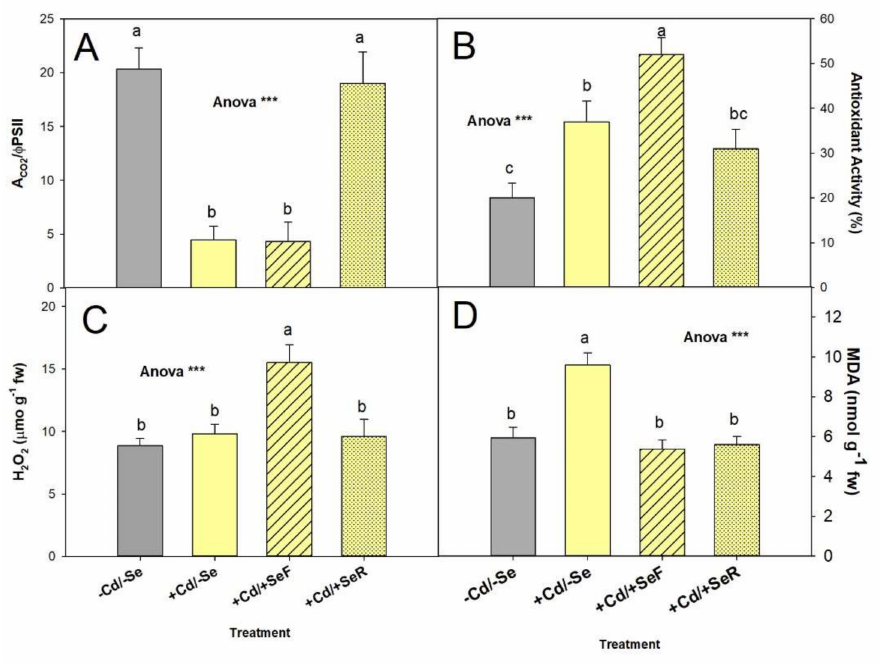
Figure 4. ACO 2 / Φ PSII ratio ( A ), antioxidant activity (%; ( B )), oxidative damage (concentration of H 2 O 2 and MDA; ( C ) and ( D ), respectively) measured in leaves from pepper plants under four treatments of cadmium and selenium ( − Cd/ − Se, +Cd/ − Se; +Cd/+SeF and +Cd/+SeR). In the ANOVA: *** indicates significant differences for p < 0.001. The different lowercase letters indicate significant differences between the treatments for p < 0.05 established by Tukey’s multiple range test. The vertical bar indicates the standard error of the